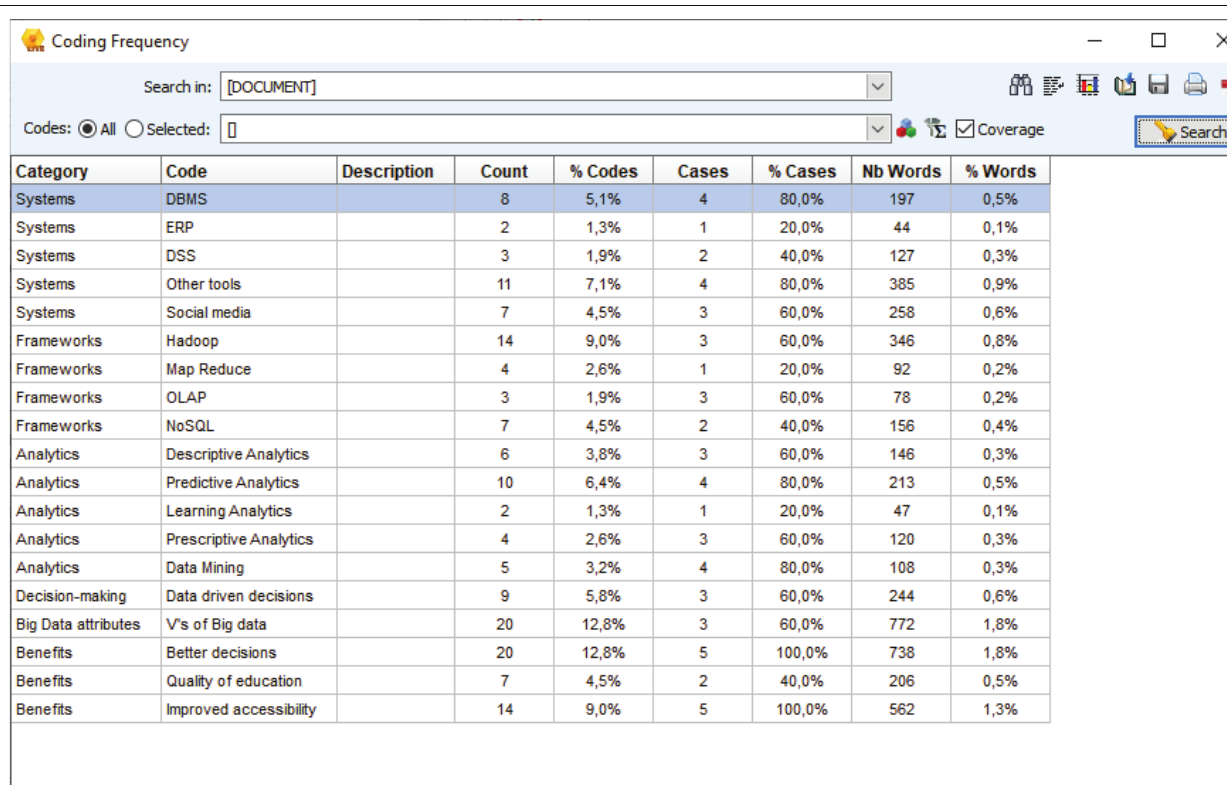
FIGURE 8: QDA Miner Lite – screenshot of themes from literature.